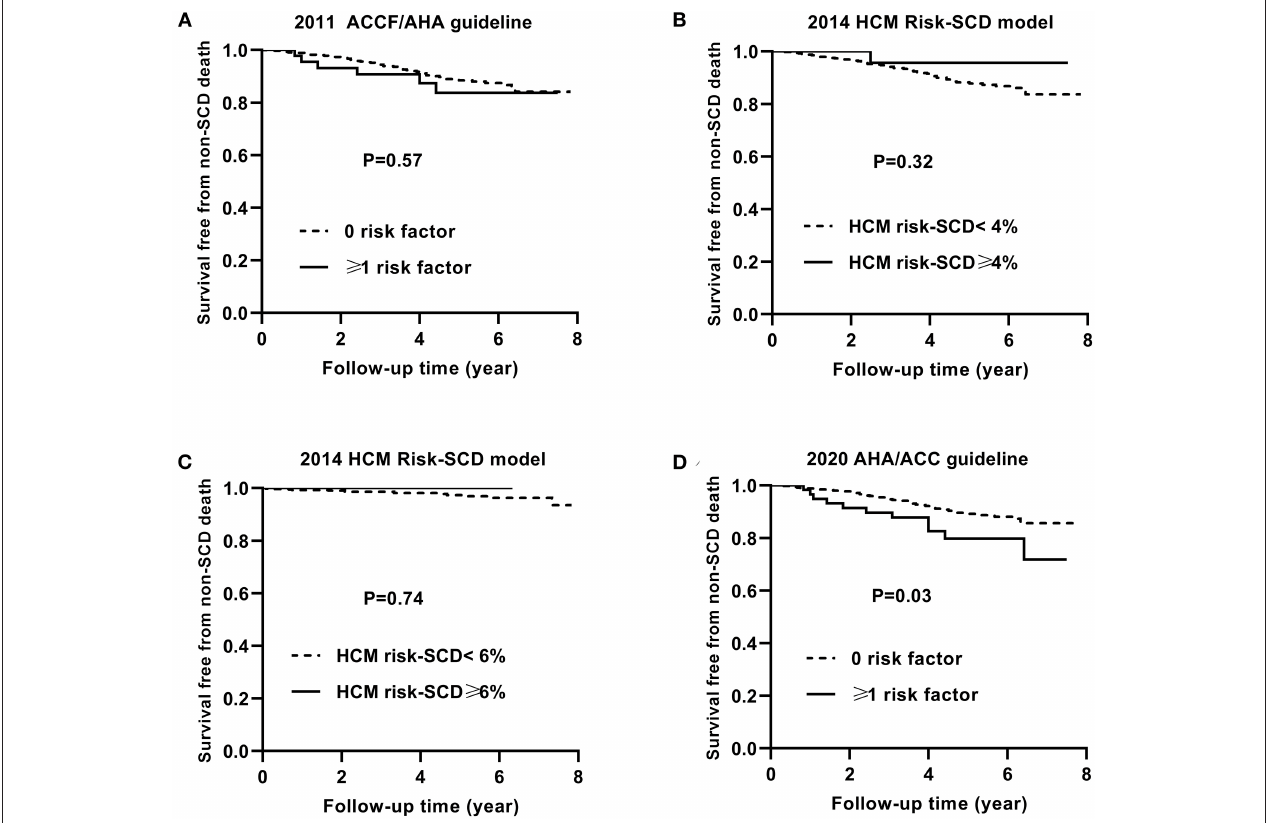
FIGURE 4 | Kaplan–Meier curves for survival free from the non-SCD death by risk stratifications based on the 2011 ACCF/AHA (A) , the 2014 ESC guideline with a cut-off level of 4% (B) and 6% (C) , and the 2020 AHA/ACC guidelines (D) . SCD, sudden cardiac death.